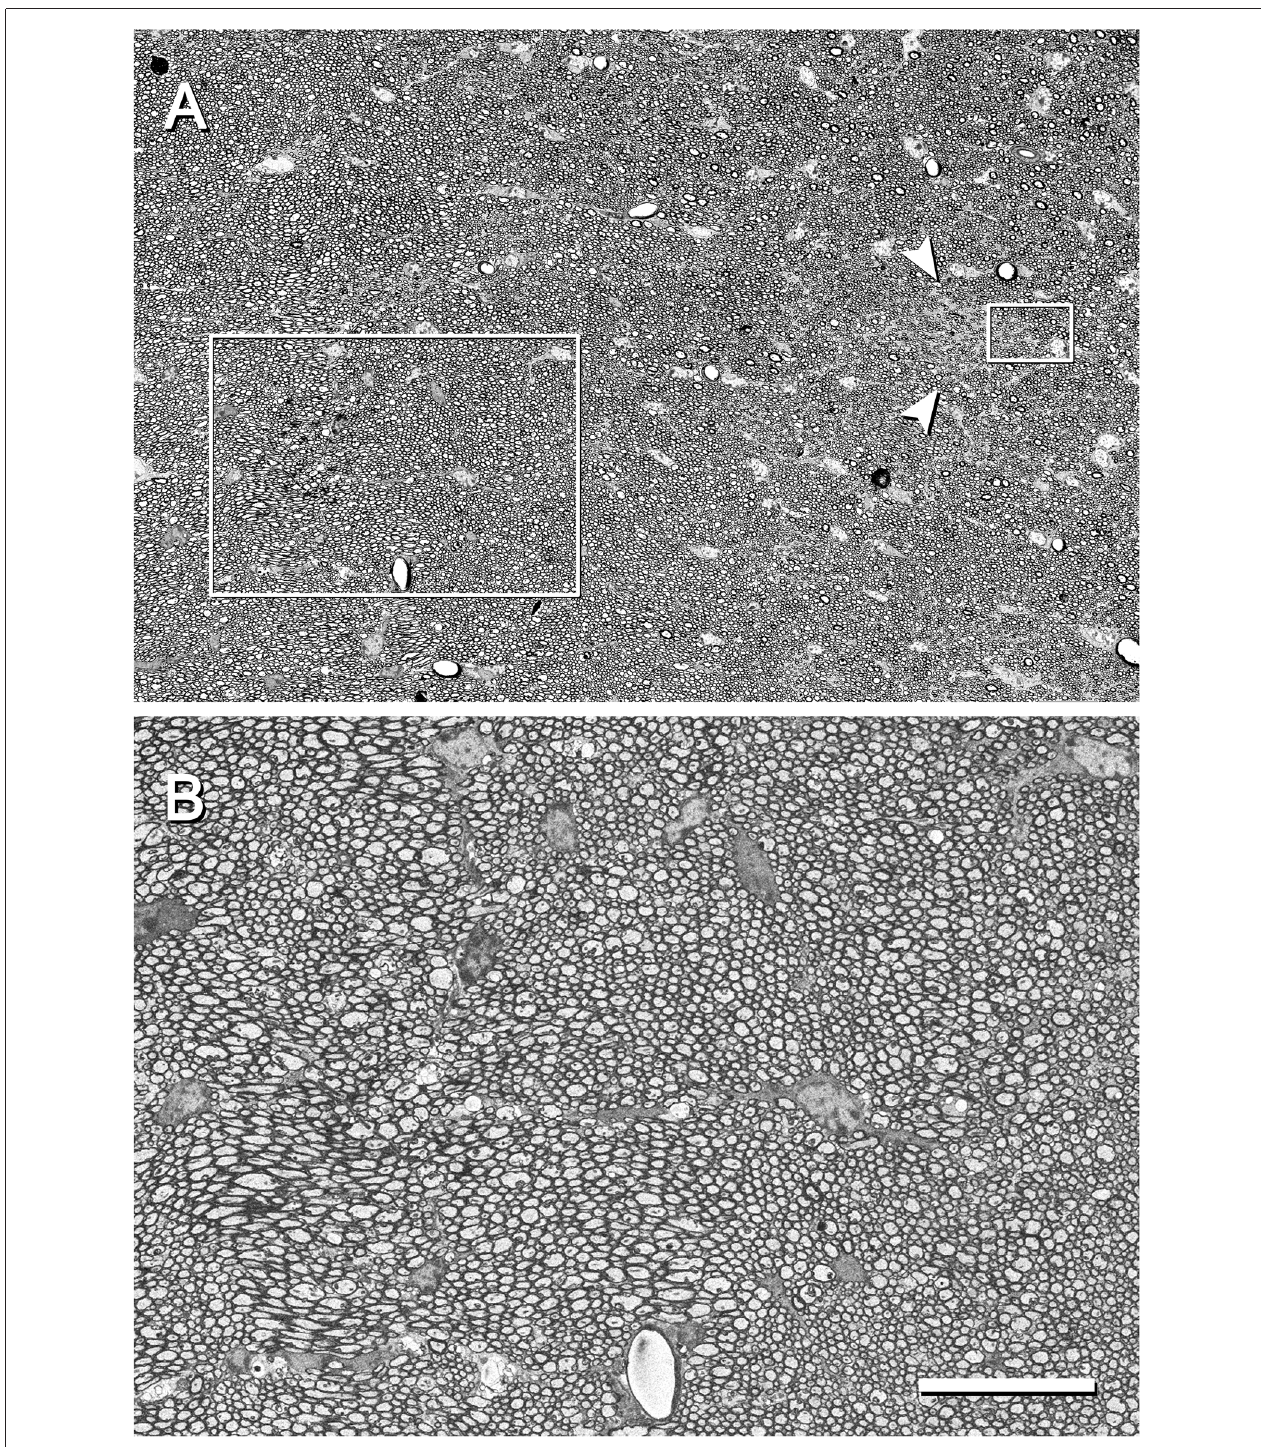
FIGURE 4 | Fimbria hippocampi of the mouse. (A) This image was acquired from the inset “b” of Figure 2 with the SE2 detector at 400 × (resolution of 139.6 nm/pixel), and an acceleration voltage of 3.0 kV. Numerous round or elliptic profiles corresponding to myelinated axons of different calibers are visible running in loosely defined bundles. Glial cells distributed throughout the whole field are also visible. Arrowheads point to a small zone that is enriched with unmyelinated fibers (see also Figure 5 ). (B) Higher magnification of the large boxed area in (A) illustrating bundles of fibers of different calibers and orientations. The image was acquired with the back-scattered electron detector (BSE) at 600 × (resolution of 93.04 nm/pixel), with an acceleration voltage of 3.00 kV. Calibration bar: 50 µ m for (A) and 18 µ m for (B) . The small boxed area in (A) is further magnified in Figure 5 .